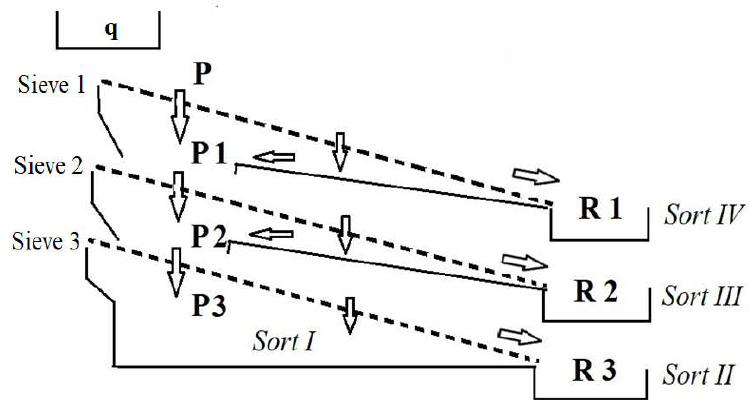
Figure 4. Scheme of sieves disposal on the industrial plant sorter